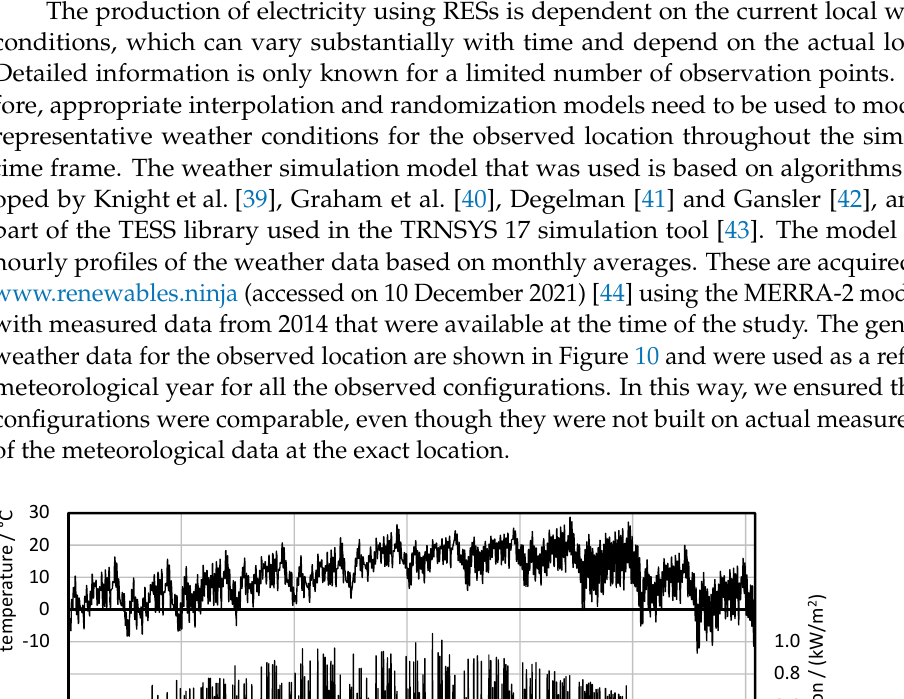
Figure 9. Duration curve of the measured and simulated loads.